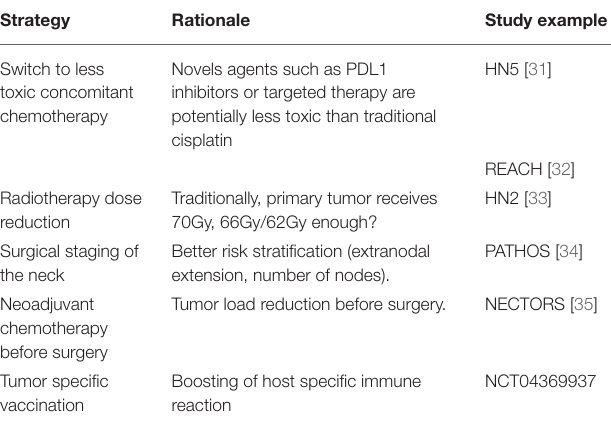
TABLE 1 | Deintensification strategies in HPV-positive oropharyngeal cancer.